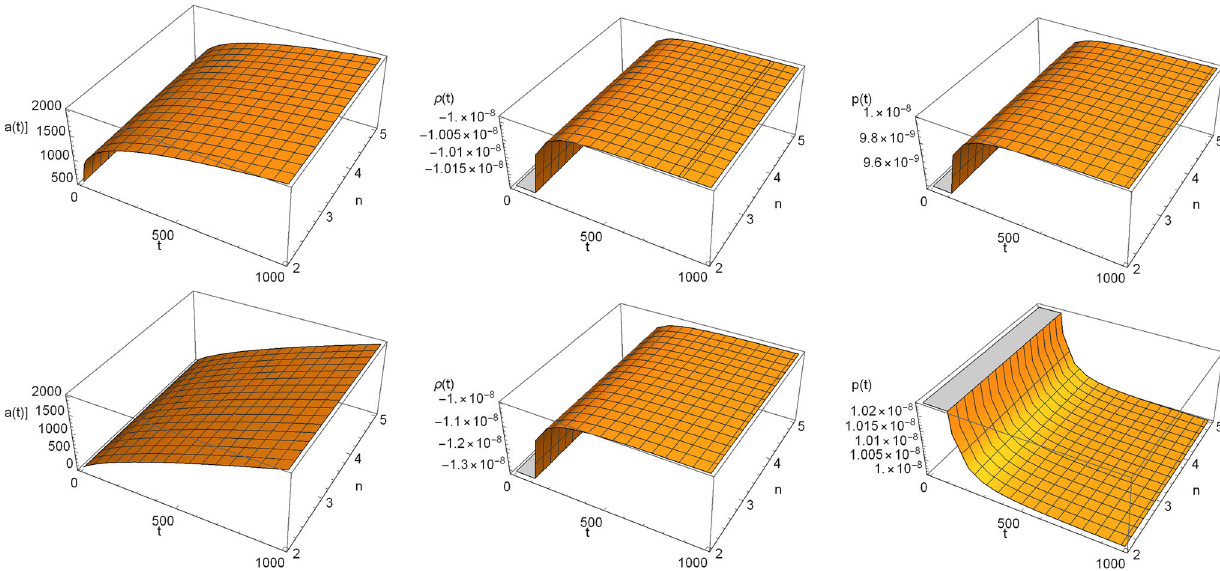
Fig. 6 The evolution of the scale factor a ( t ) , density ρ( t ) and pressure p ( t ) for typical values of q = 0 . 2 in the upper plot and q = 0 . 8 in the lower plot. We have set a s = 2000 , a ES = 0 . 01 , t s = 1000 , λ =